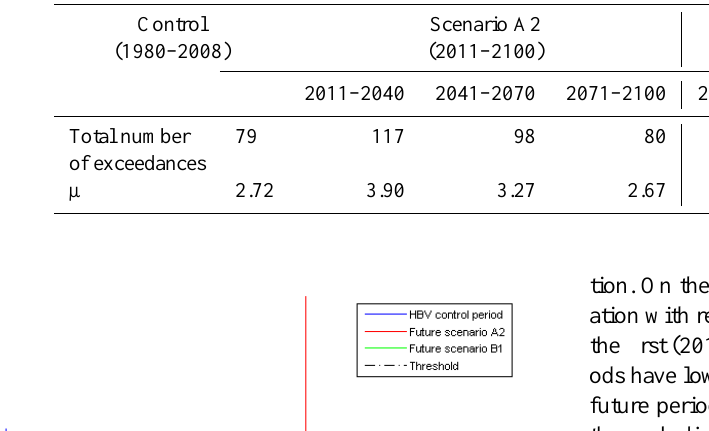
Table 2. Summary of the number of POT of the Alt Llobregat sub-basin for the three study periods and the two scenarios.